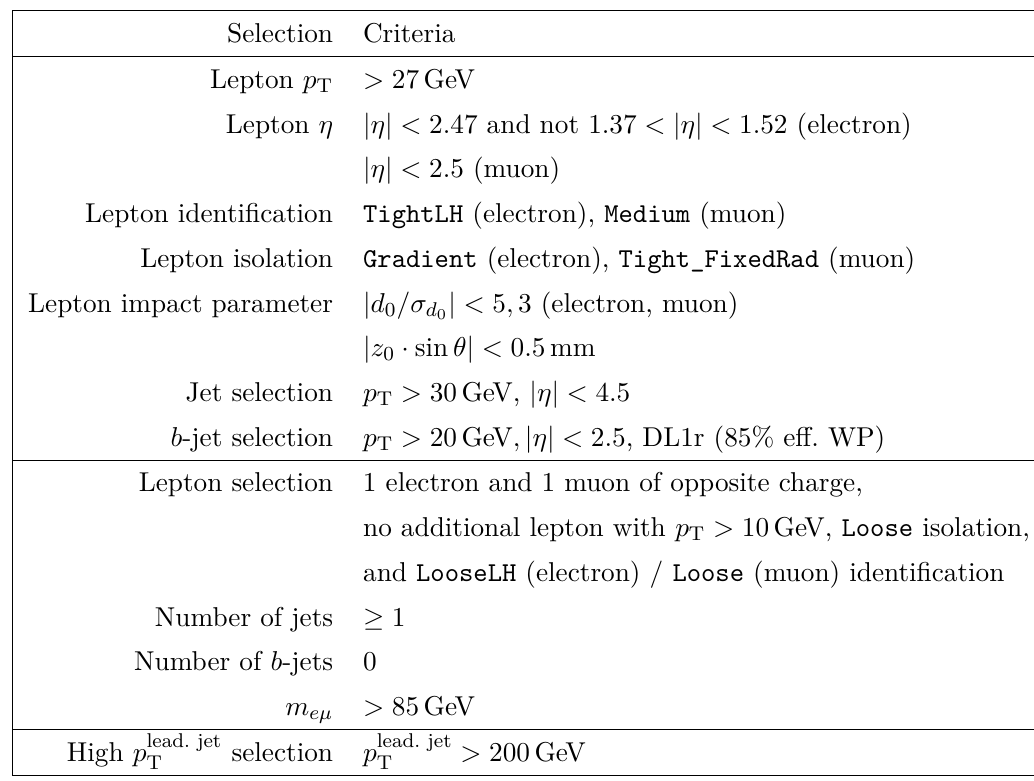
Table 2 . Summary of the object and event selection